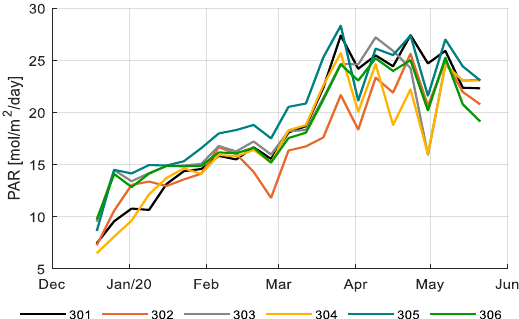
Figure 5. Weekly average total daily photosynthetically active radiation (PAR) light integral (mol/m 2 /d) (natural sunlight and artificial lighting) in the greenhouse compartments (301–306).